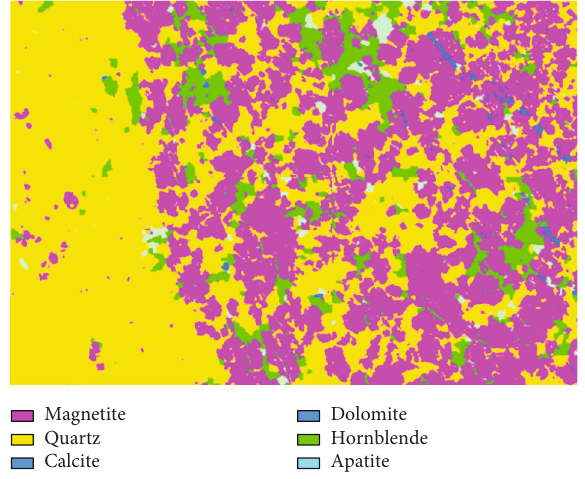
Figure 1: MLA image of the ore sample. Table 1: Raw-ores mineral phases identi fi ed by